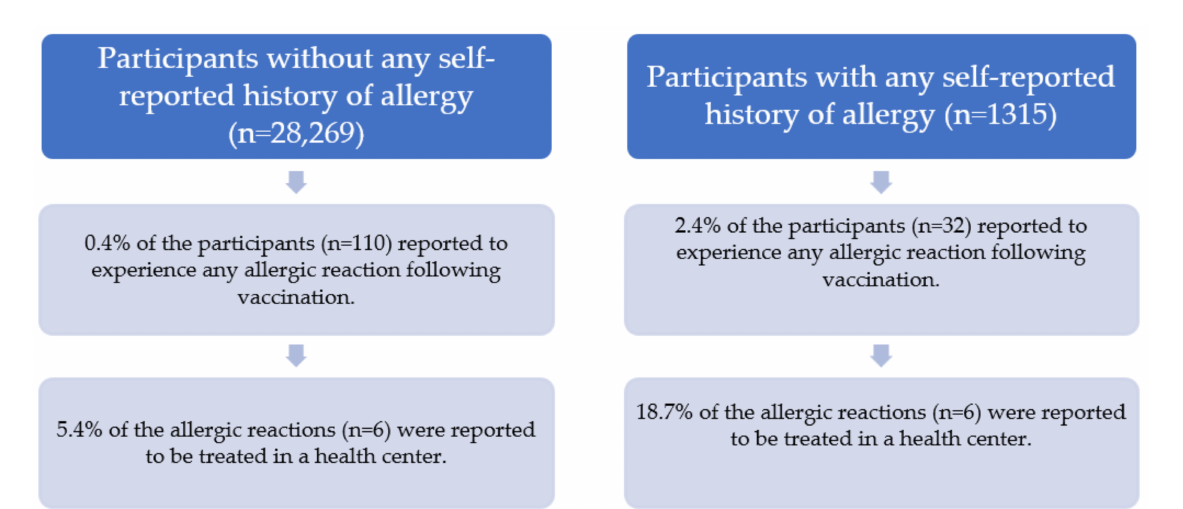
Figure 1. Comparison of experience of any allergic reaction and self-reported history of allergy following the